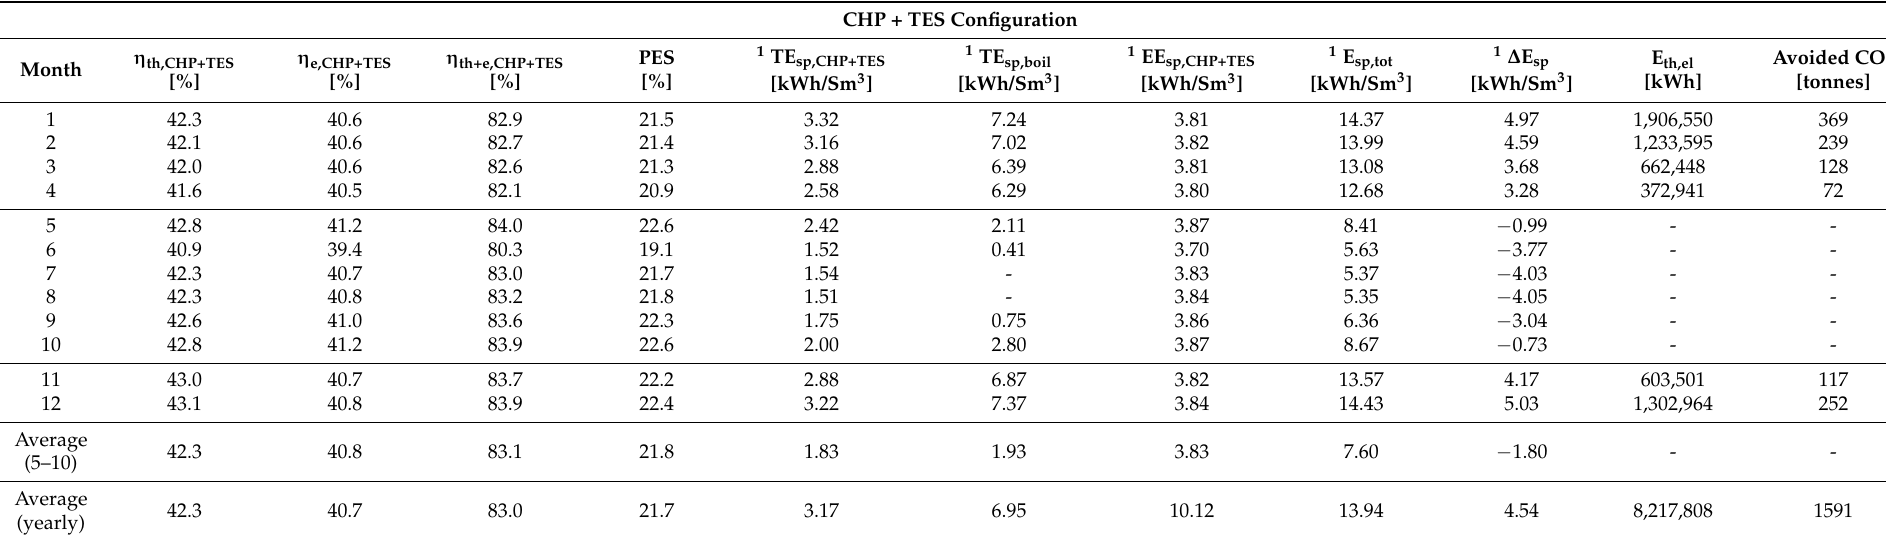
Table 7. Monthly parameters of CHP + TES configuration (year